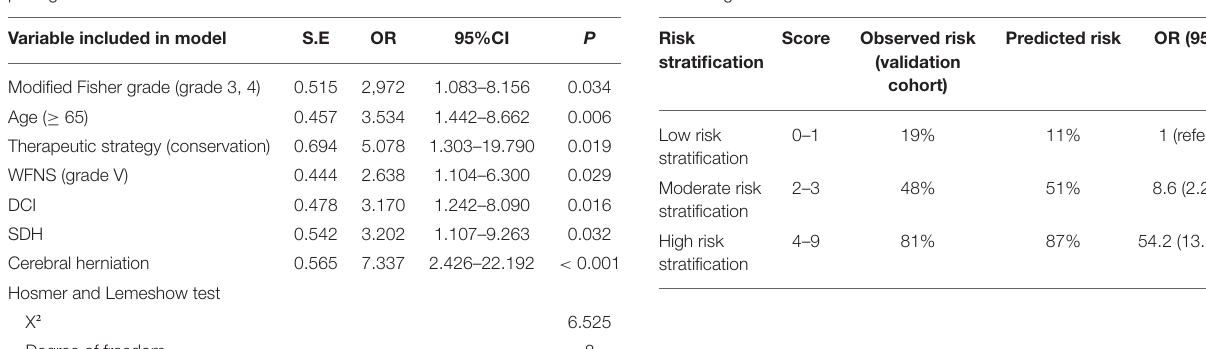
TABLE 4 | Risk of poor prognosis for low, intermediate, and high-risk individuals according to the PASHPSS risk